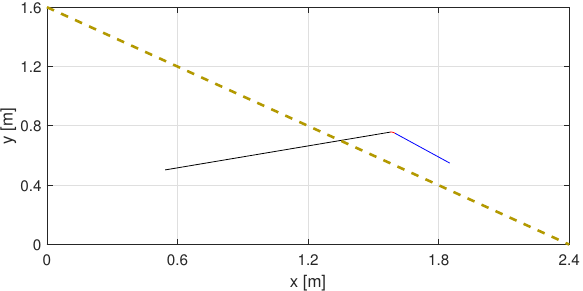
Figure 9. Trajectory of the end-effector in the x − y plane: in blue, the nominal trajectory before failure, in red, the connecting path and in black, the straight line path.